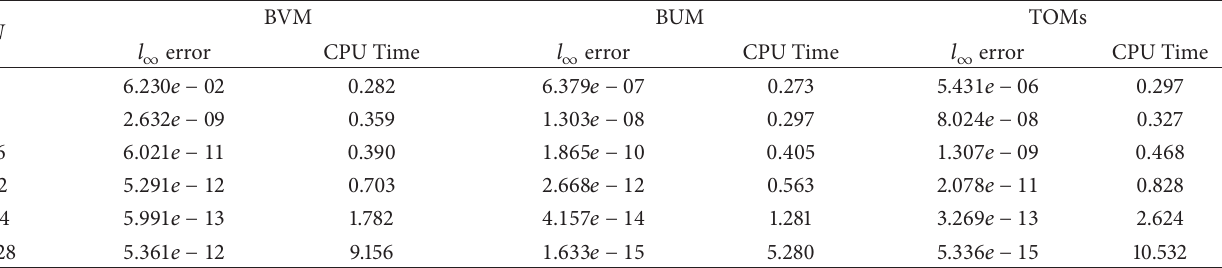
Table 7: Computational results for V = 2 for Example 5.4.